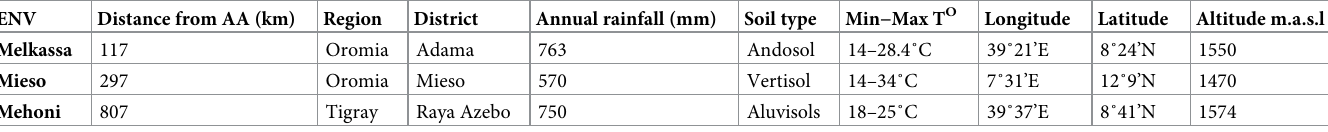
Table 1. Description of the testing